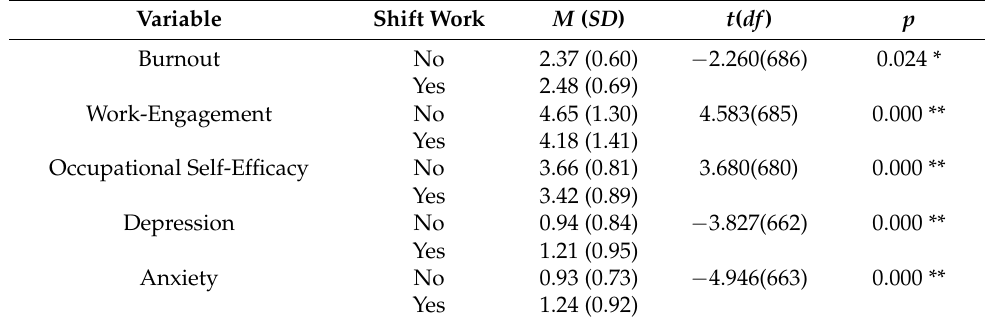
Table 4. Results for Burnout, Work-Engagement, Occupational Self-Efficacy, and Mental Health Symptoms by shift